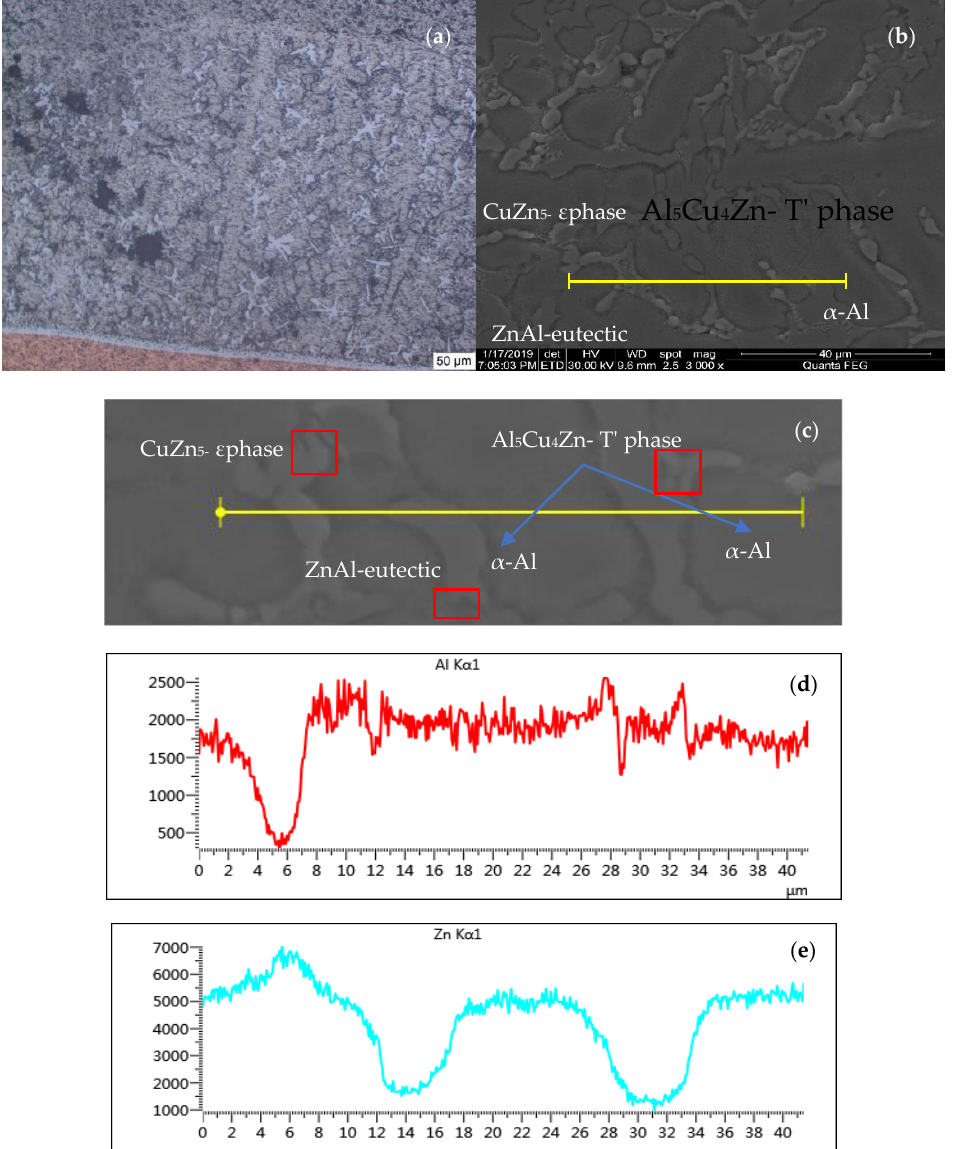
Figure 4. The dendrite microstructure OM diagram, SEM morphology diagram and line scan diagram of the brazed joint area of common sample: ( a ) OM morphology of dendrite in brazed zone; ( b ) SEM morphology of dendrite structure in brazed zone; ( c ) Linear scanning composition of dendrites in brazed joint microstructure; ( d ) Line scan for Al composition; ( e ) Line scan for Zn composition.